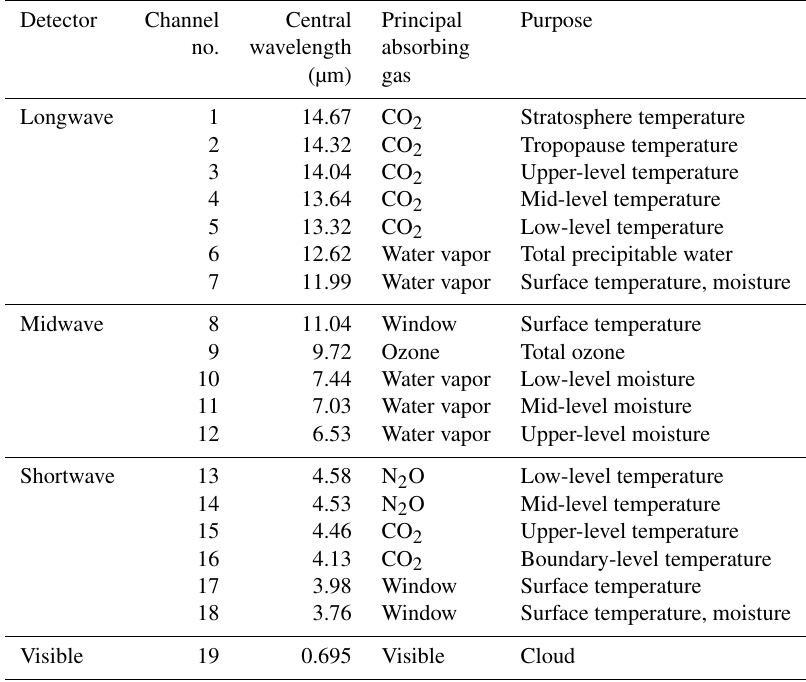
Table 1. INSAT-3DR sounder channel specifications.